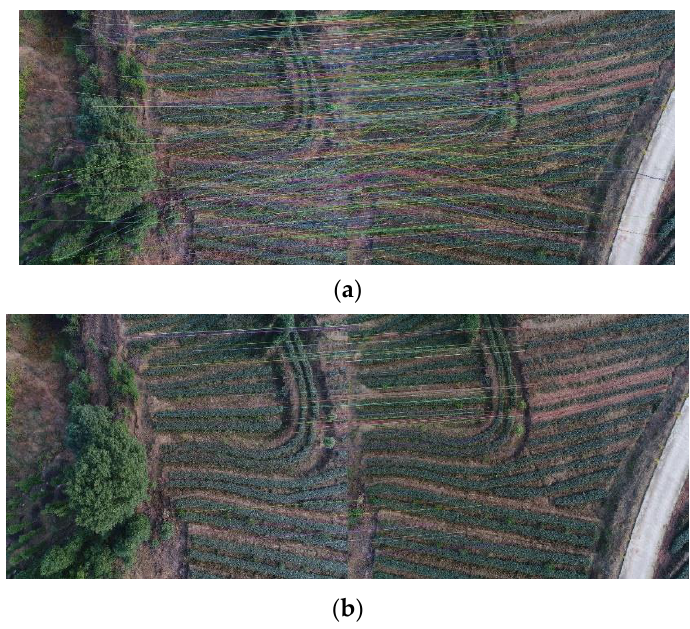
Figure 7. Matching effects of the ( a ) rough match and ( b ) exact match.